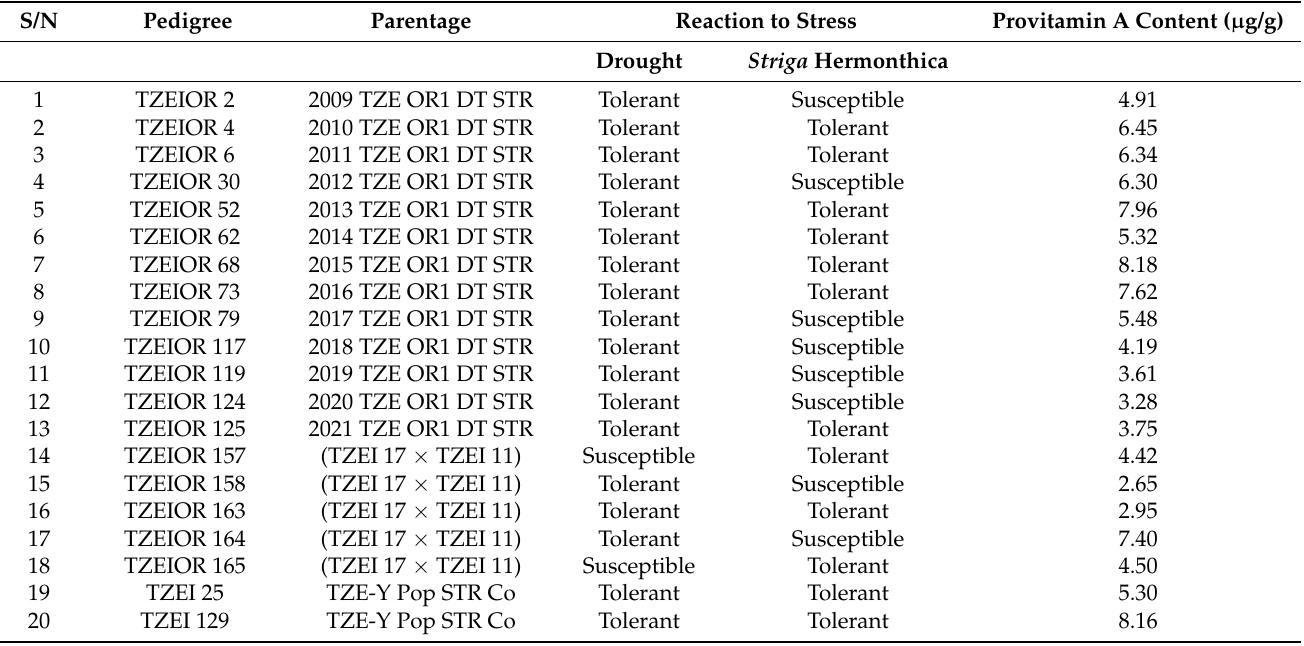
Table 1. Characteristics and parentage of early-maturing maize inbred lines used for the diallel